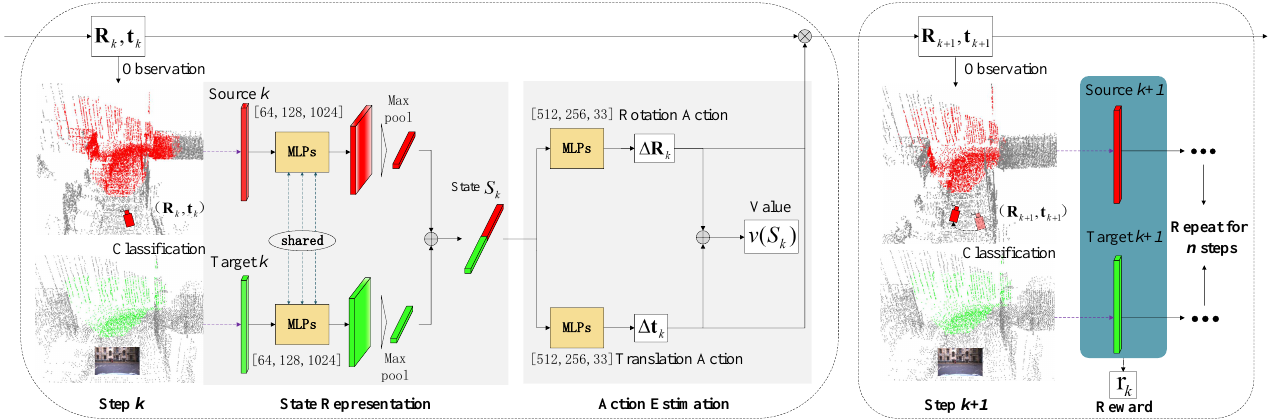
Figure 3. The overall architecture for one iteration of AgentI2P. At each step k , given the present camera pose R k , t k and dual-classification result, two frames of point clouds (Observation Source and Classification Target) are [treated] as the input. The policy network repetitively learns to embed the current state and predict the update action along rotation and translation axes, which promotes the virtual camera to the next pose. Please see Section 3.3 for more details on the network